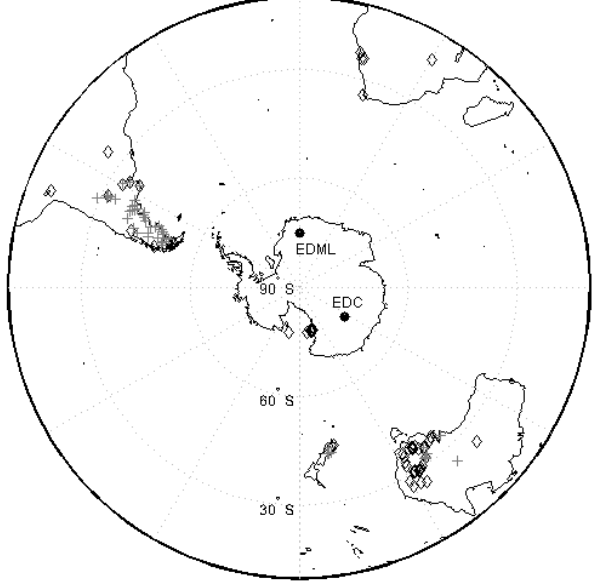
Fig. 1. Map of sample locations. Diamonds indicate samples from this study, crosses represent previously published data (see text for references). EDML and EDC indicate the drill sites for the two deep ice cores drilled within the framework of EPICA in Dronning Maud Land and at Dome